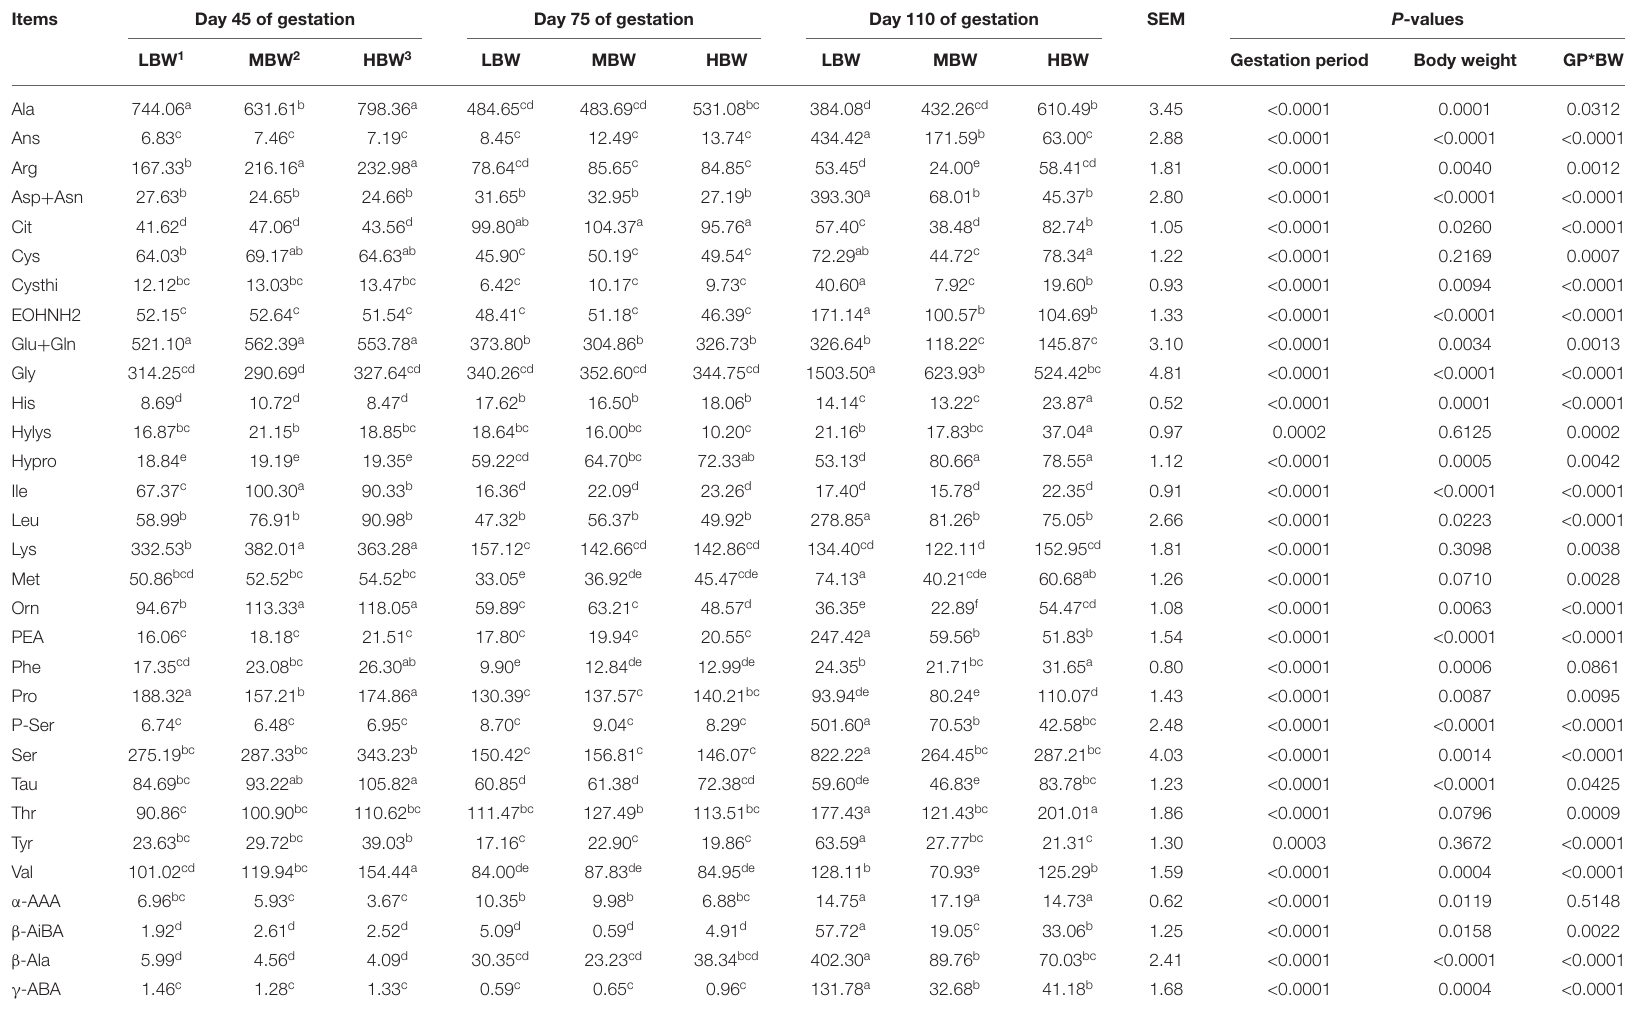
TABLE 6 | Free AA profiles in amniotic fluid of fetal pigs with LBW, MBW, and HBW at different gestation period (nmol/ml).